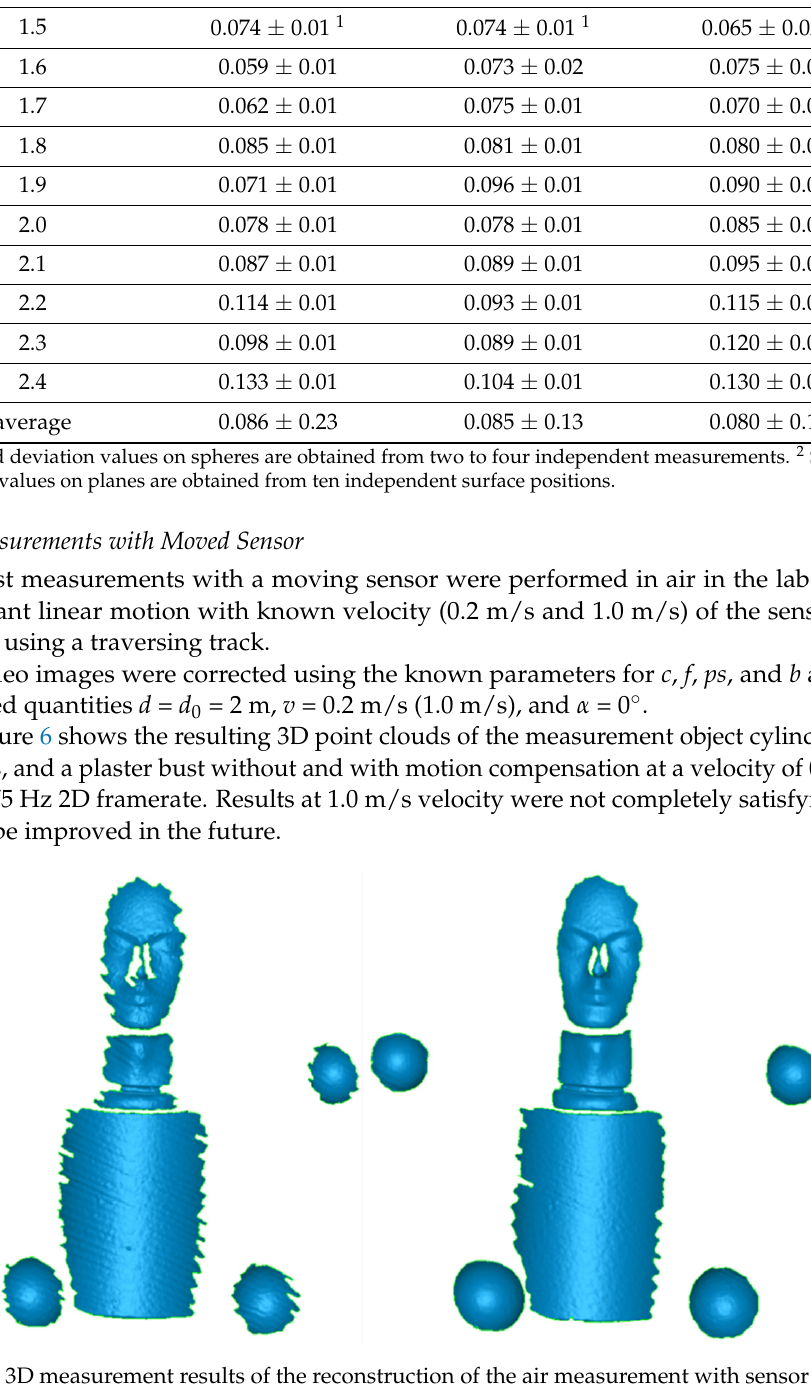
Figure 7. 3D reconstruction result of underwater pipe measurement at 0.7 m/s sensor velocity with- out motion compensation (MC) ( left ), manual MC ( middle ), and automatic MC ( right ).